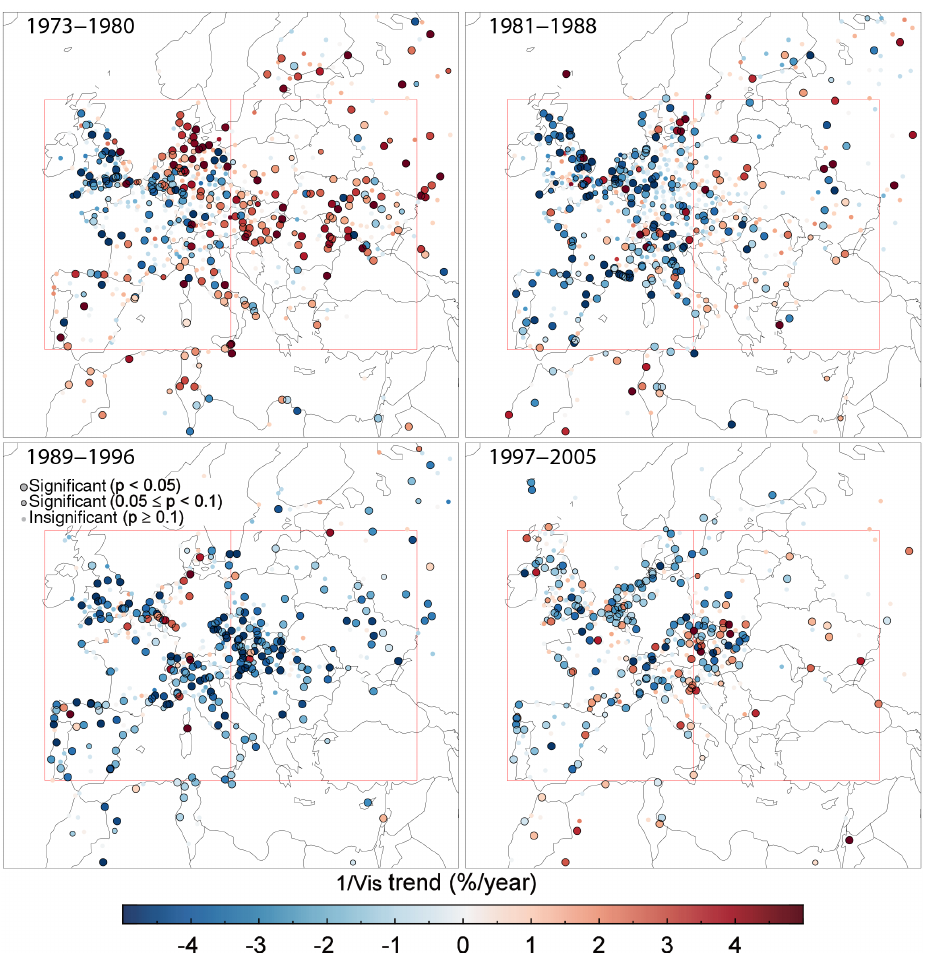
Figure 9. Spatial distribution of relative trends in 1/Vis over Europe for 1973–2005. Larger colored points with black outline indicate trends with at least 95% significance, smaller colored points with black outline represent trends with 90–95% significance, and colored points without outline indicate insignificant trends. Red rectangles define the eastern and western Europe regions for composite time series analysis in Fig. 10.